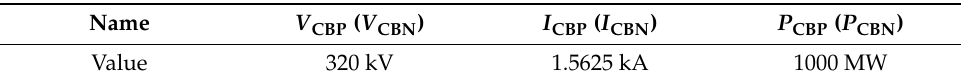
Table 2. Voltage and current ratings of the DCCB in the simulated UUDAT.